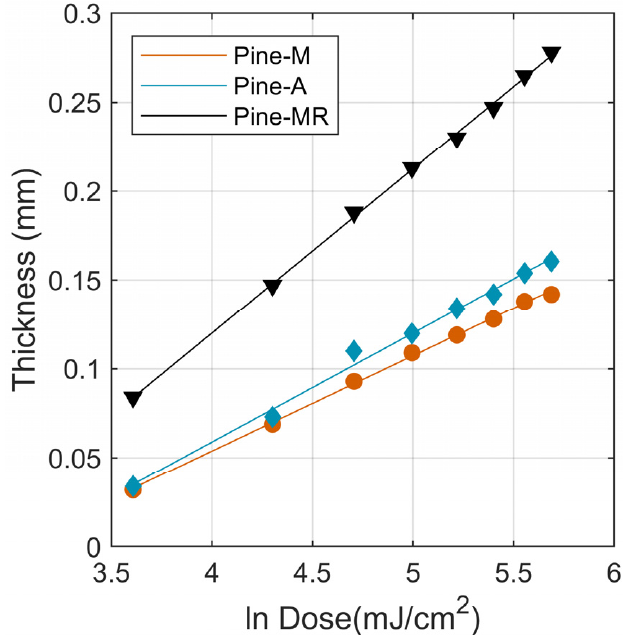
Figure 3. Representative working curves for lignin resins made with modified lignin.